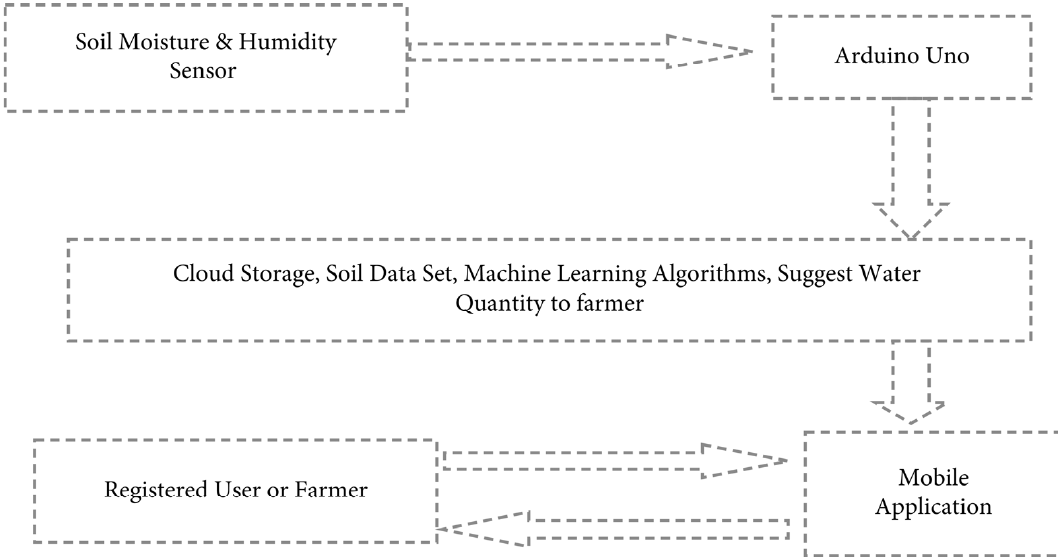
Figure 4. A framework for smart irrigation [55].